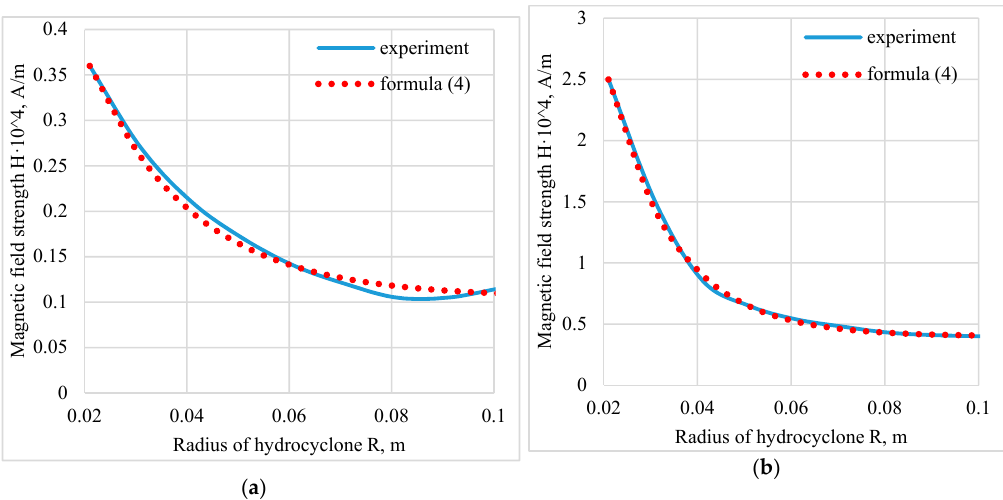
Figure 4. Change in magnetic field strength along the radius at various currents in the winding: ( а ) I = 1 А , n 1 = 4; ( b ) I = 8 А , n 1 = 5.7.